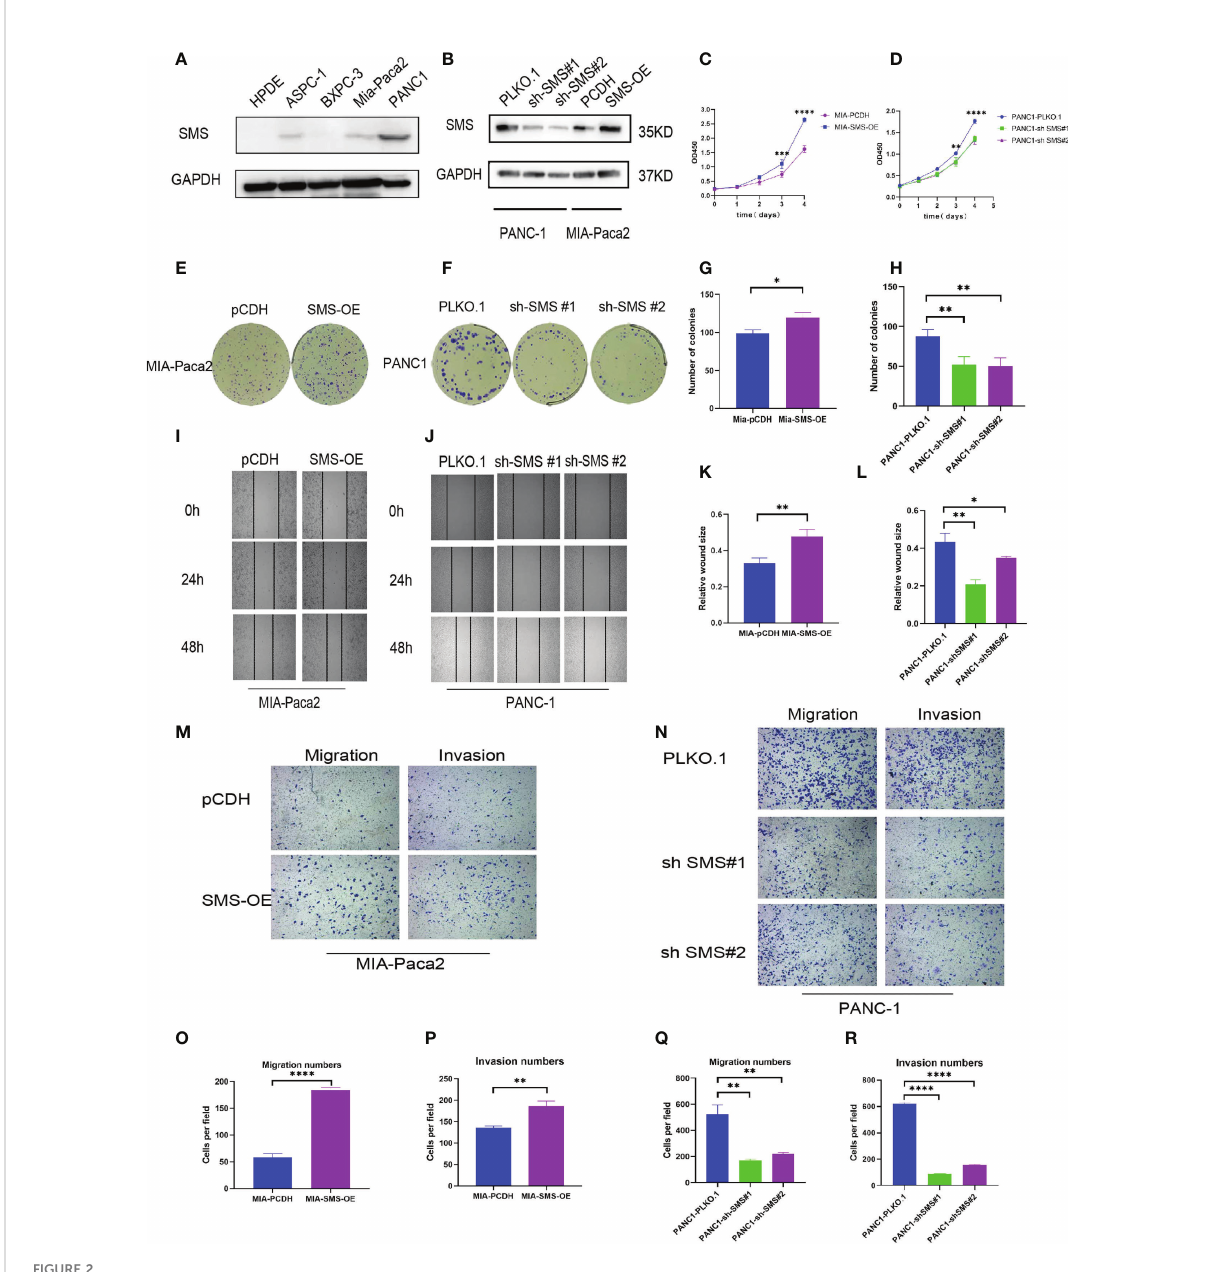
FIGURE 2 SMS can promote the growth, migration and invasion of pancreatic cancer. (A) The protein levels of SMS in normal human pancreatic duct epithelial (HPDE) cells and selected human pancreatic cancer cell lines were quantitated by western blot assays. (B) Mia-Paca2 cells with stable SMS overexpression PCDH-SMS-OE and PANC-1 cells with SMS knockdown PLKO.1-shSMS#1 and PLKO.1-shSMS#2 were generated. The changes in SMS expression were conformed using western blot. (C, D) The proliferative ability of stably transfected PANC-1 or Mia-Paca2 cells was investigated via CCK-8 assays. (E-H) Representative colony formation images are shown (E, F) , and the numbers of colonies were summarized (G, H) . (I-L) Wound-healing assays with stably transfected Mia-Paca2 (I) and PANC-1 (J) cells were performed. Representative images and quantifcation of wound closure are presented (K, L). (M-R) Transwell assays with stably transfected Mia-Paca2 (M) and PANC-1 (N) cells were performed. Representative images and quantifcation of the results are presented. (O-R) *P < 0.05; **P < 0.01; ***P < 0.001; ****P <